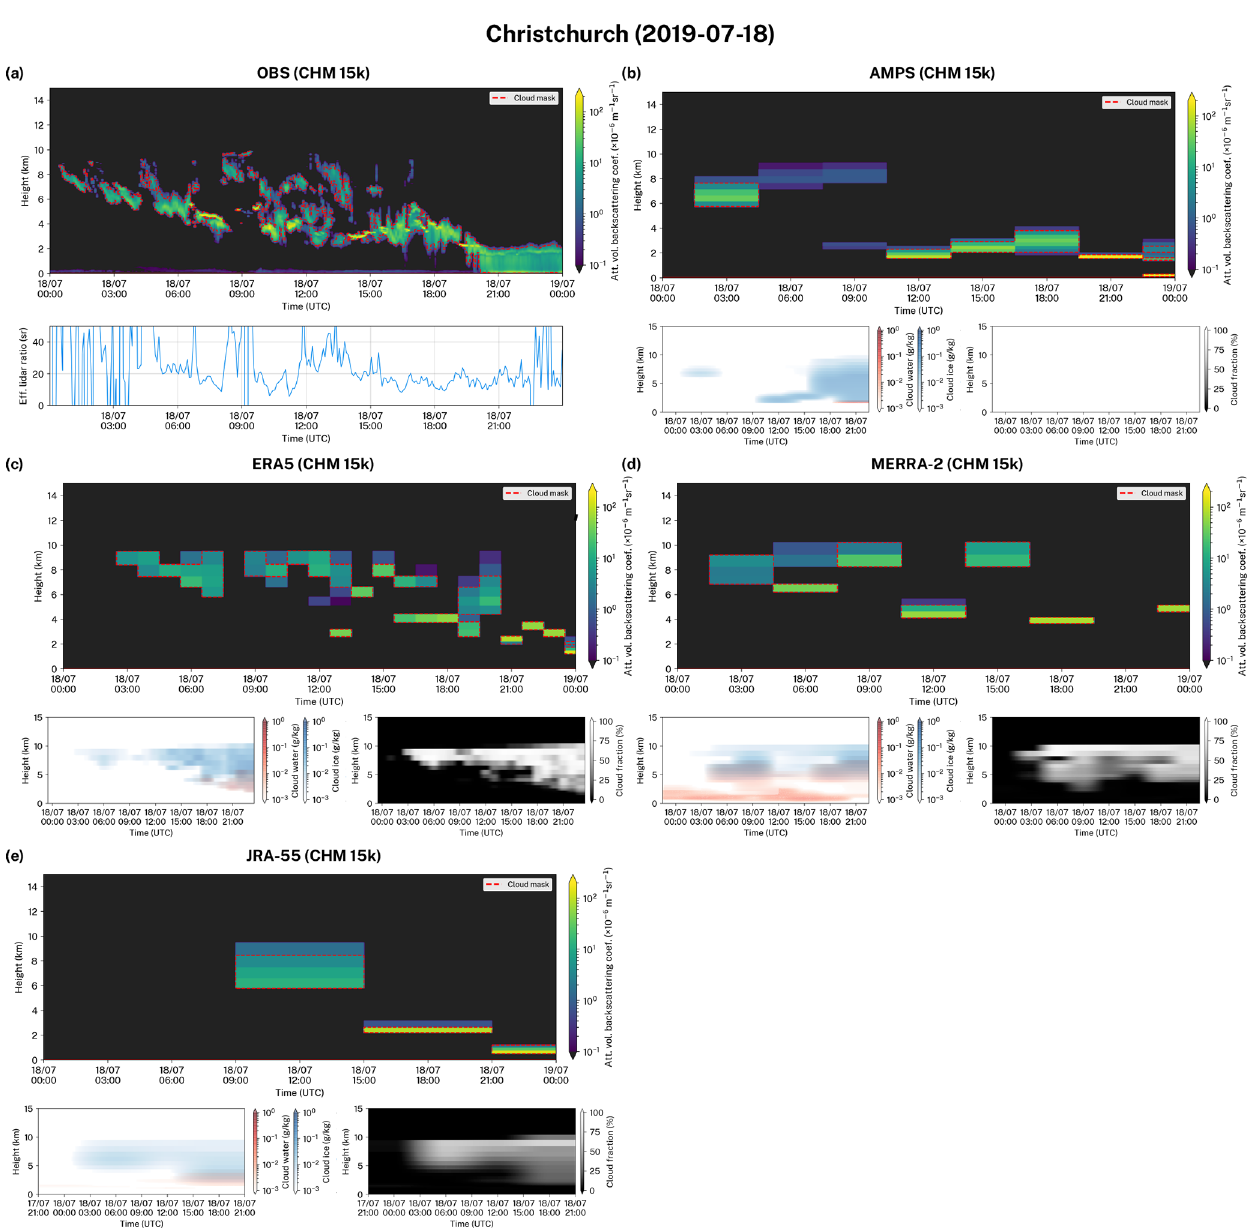
Figure 6. The same as Fig. 4 but for the